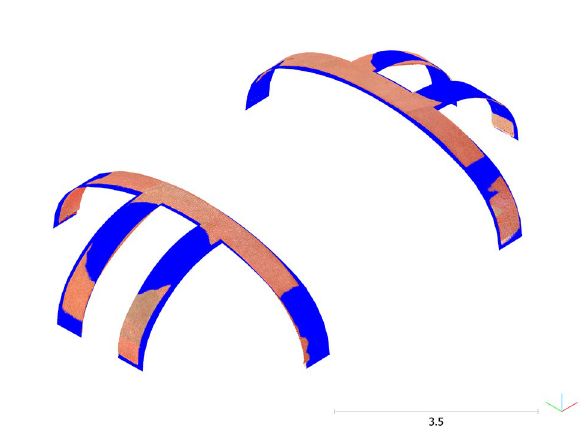
Figure 14 . 3D model view of independent arches realized in Grasshopper (Processing: F. Natta).